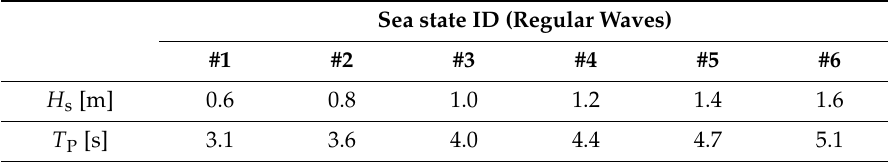
Table 3. Sea states applied to each control law of the test plan in Table 2.